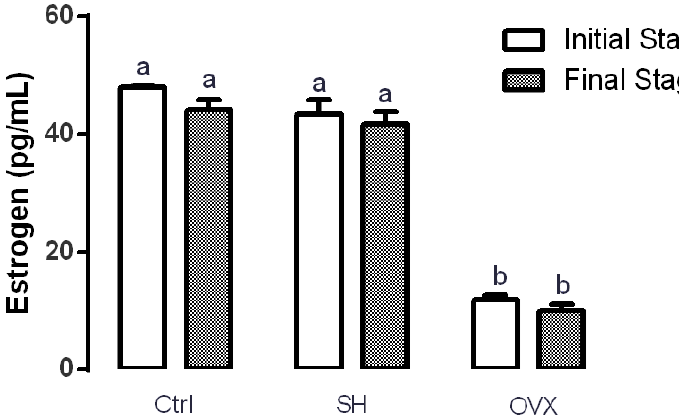
Figure 1. Effect of ovariectomy in serum estrogen levels at the beginning and at the end of the treatment. The results represent the average ± SD of the experimental groups, n = 5 in control (Ctrl), sham (SH) and ovariectomized (OVX) groups. Means in bars with different letters indicate significant differences ( p ≤ 0.05) between groups with Tukey’s test.